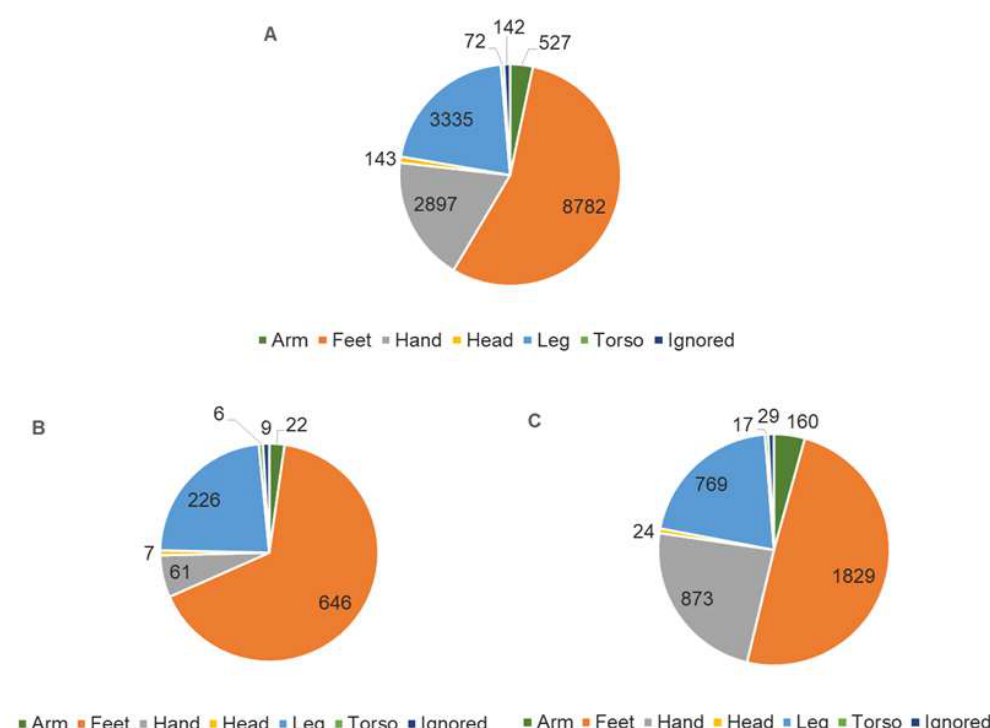
Figure 3. Number of snakebites by site on the body; total ( A ), the most exposed race group (indige- nous) ( B ), and the less exposed (white) ( C ), rural population, Brazil, 2017.